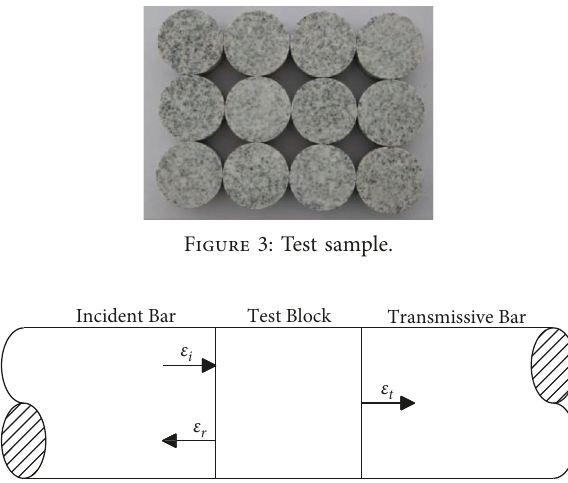
Figure 4: Schematic diagram of SHPB impact compression test loading.